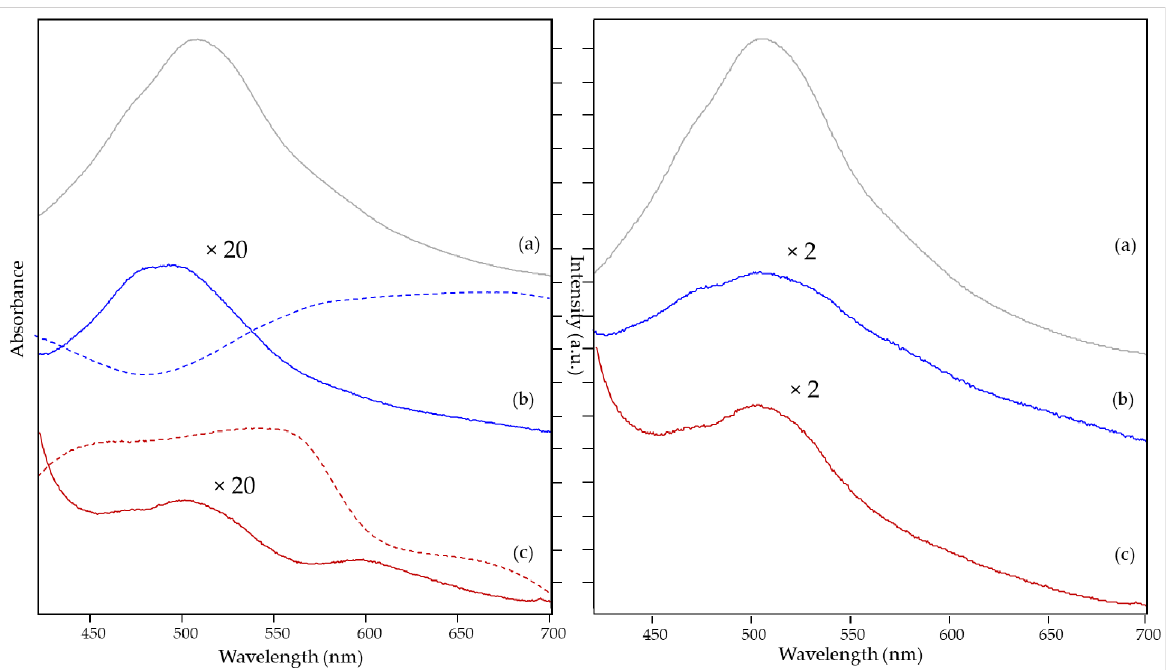
Figure 3. ( Left ): emission ( λ exc = 365 nm) (solid lines) and absorption (dashed lines) spectra of mock- up samples prepared with different pigments in linseed oil (1- or 2-years old). ( Right ): emission spectra ( λ exc = 365 nm) of the same pictorial layers after self-absorption correction. Spectra ( a ) refer to lead white (grey lines), ( b ) to azurite (blue lines) and ( c ) to hematite (red lines).